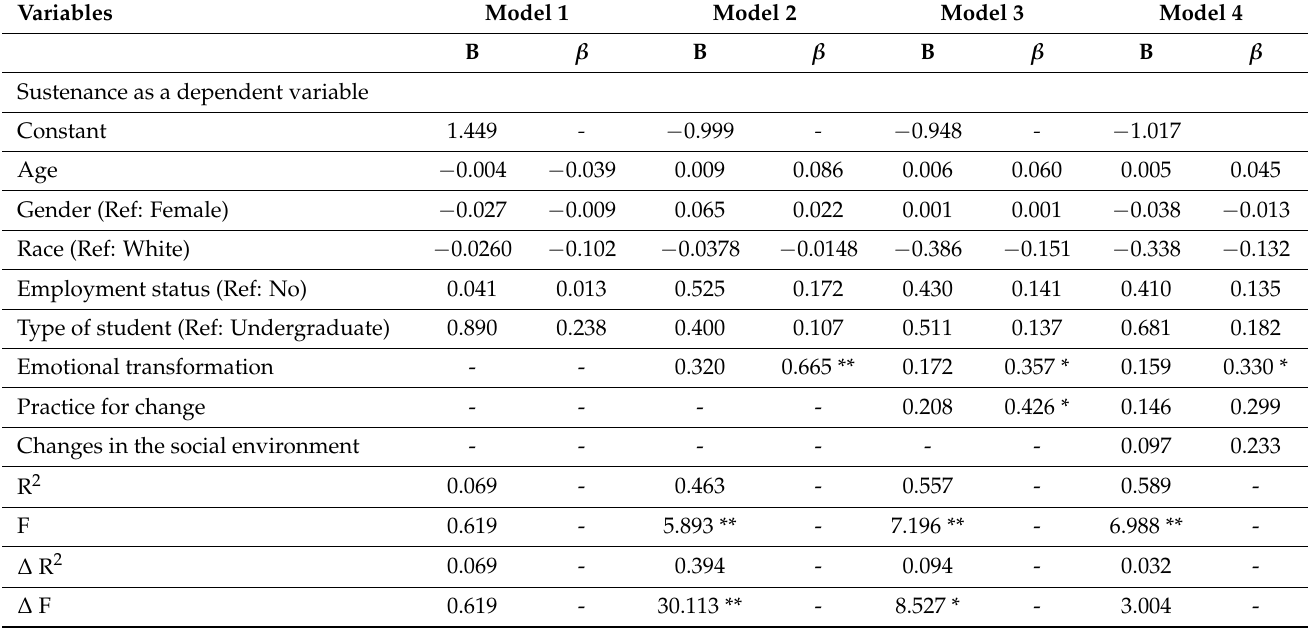
Table 5. Hierarchical regression to predict likelihood for sustenance of introspective meditation among participants who were not engaged in the practice ( n =